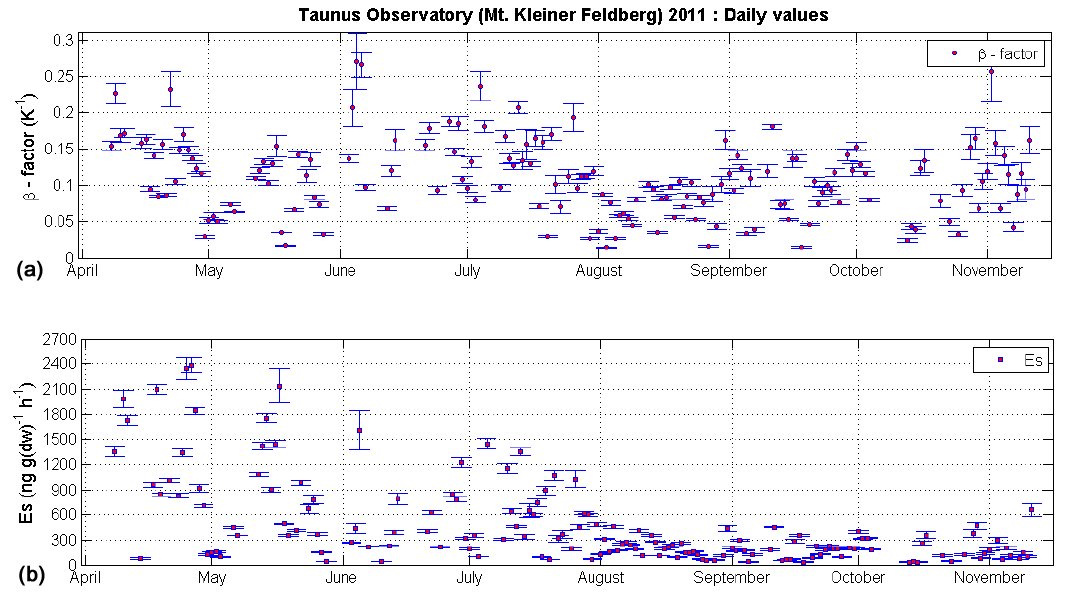
Fig. 2. β -factor (upper plot) and emission potential E s ,T (lower plot) derived from daily regression